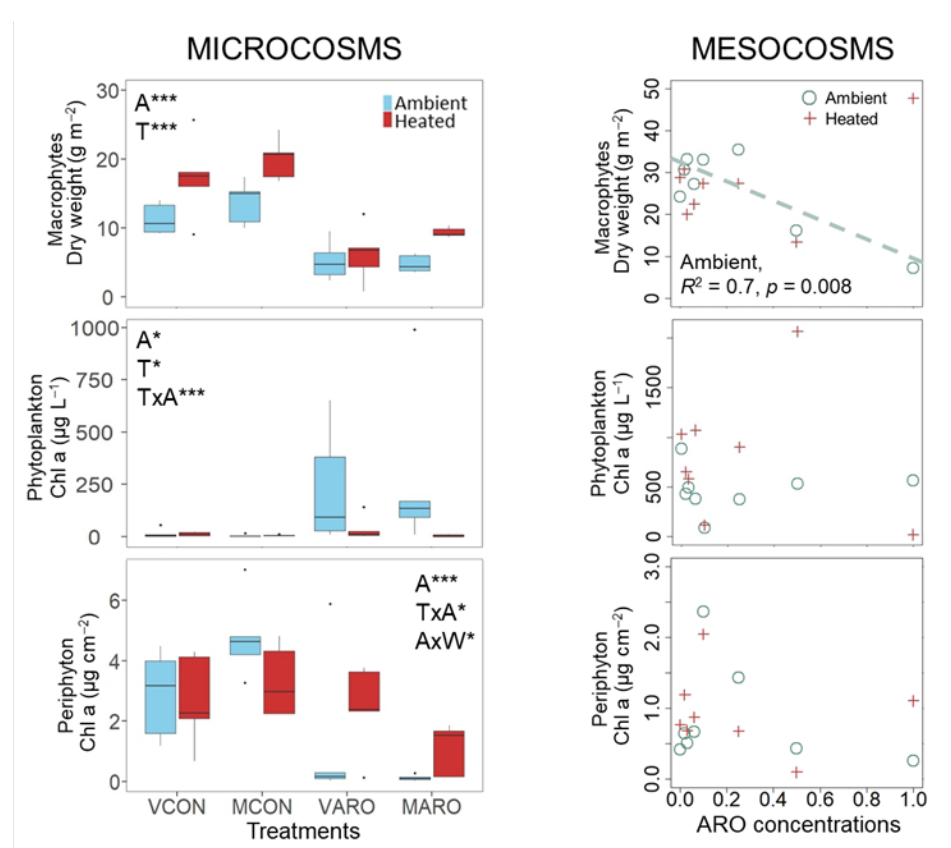
Figure 3. Stressor effects on the final aboveground biomass of all macrophytes, chl- a concentra- tion of phytoplankton and periphyton in the microcosms ( left ) and mesocosms ( right ). Micro- cosms: VCON = Volvic control; MCON = Munich well water control. ARO; VARO = Volvic ARO; MARO = Munich well water ARO. Box plots of 5 replicates showing the median, 25 and 75% per- centiles, lowest and highest whiskers (as Q1 − [1.5 × IQR] and Q3 + [1.5 × IQR], respectively), and outliers (dots). A = ARO, T = Temperature and W = Water. Mesocosms: Regression plots with the ARO concentration gradient along the x -axis. Mesocosms: R 2 and p -value from the linear regression. For the microcosm experiment, the significance levels are shown as * p < 0.05; *** p < 0.001.